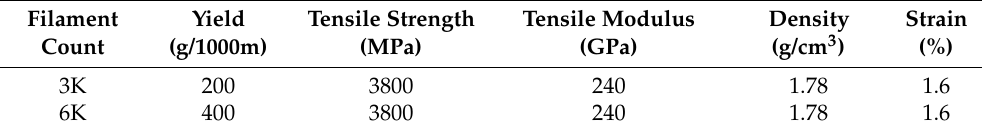
Table 1. Typical properties of carbon fibre and fabric parameters.